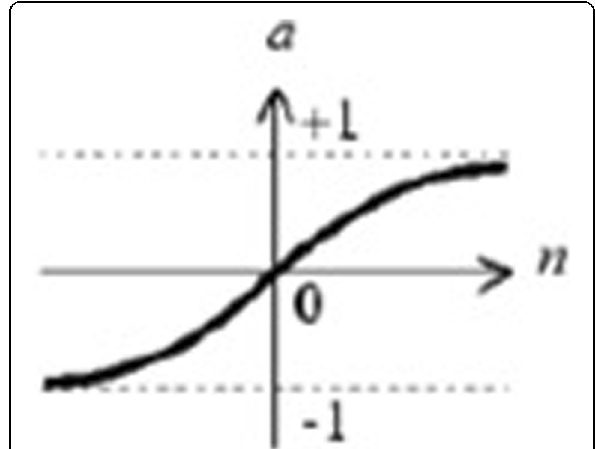
Fig. 15 Hyperbolic tangent sigmoid transfer function